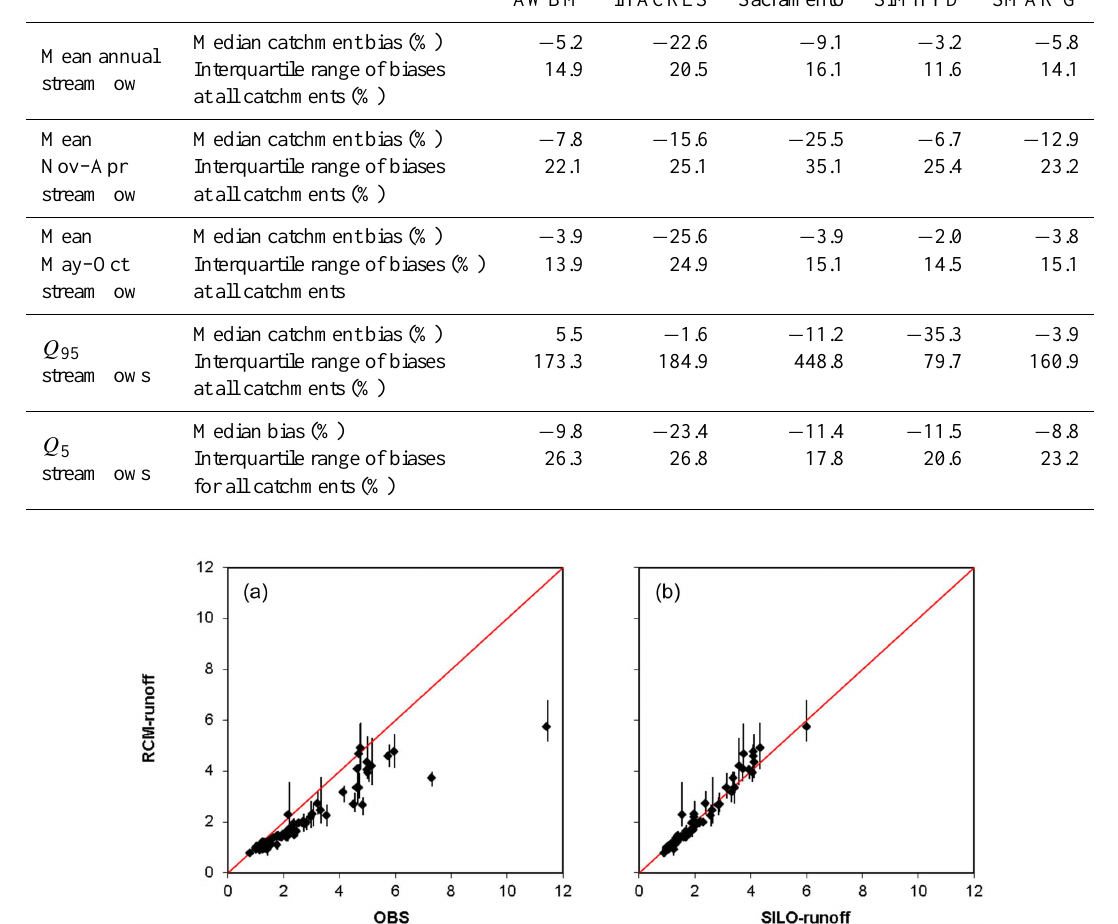
Fig. 7. Comparison of coefficients of variation (CV) of daily streamflows generated by SIMHYD at 86 streamflow gauges for 1961–2007. (a) CV of daily streamflows generated by SIMHYD forced with the RCM (RCM-runoff) and observations (OBS). (b) CV of daily streamflows generated by RCM-runoff and SIMHYD forced with SILO (SILO-runoff). Points show the mean of the six RCM simulations, bars show the range from the six